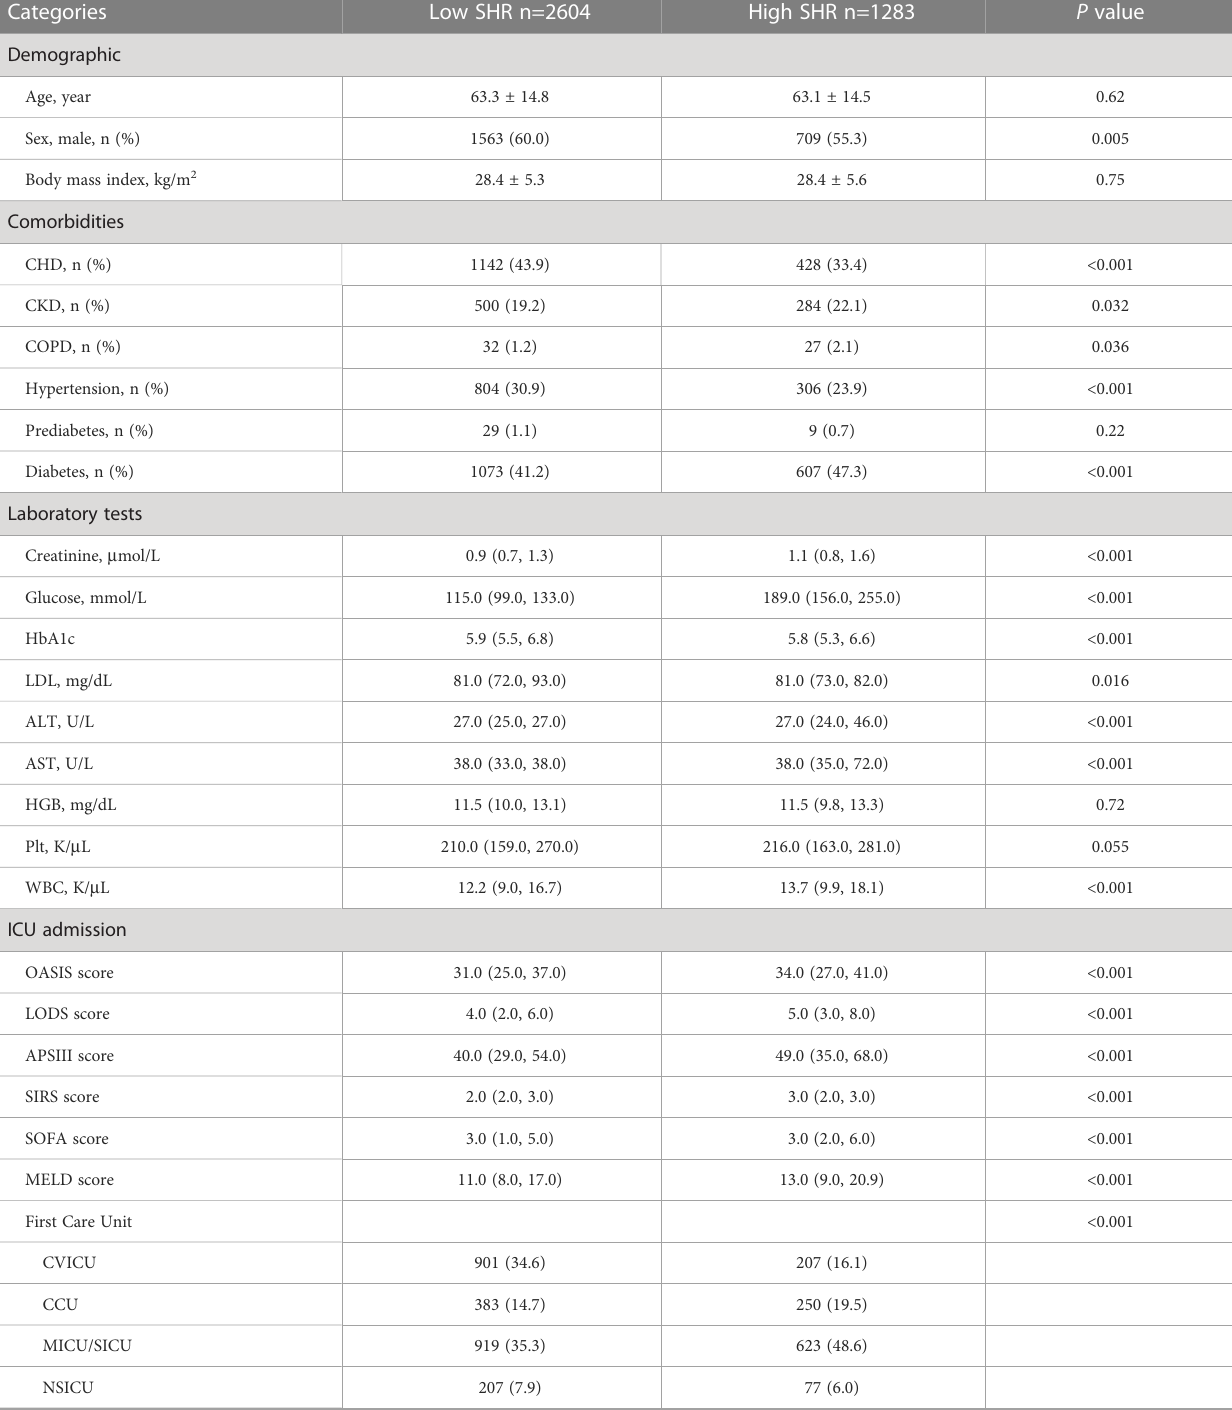
TABLE 1 Baseline characteristics and events of cohort